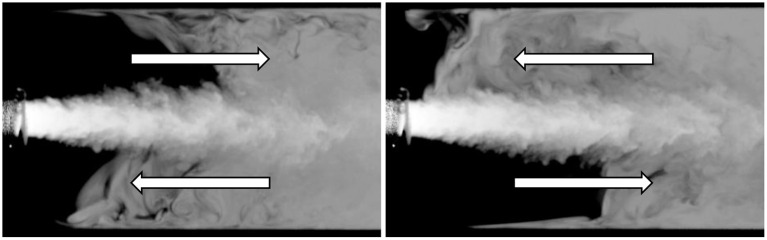
Instantaneous flow field of the mixture fraction for the Case 1SC with a 1 s interval.